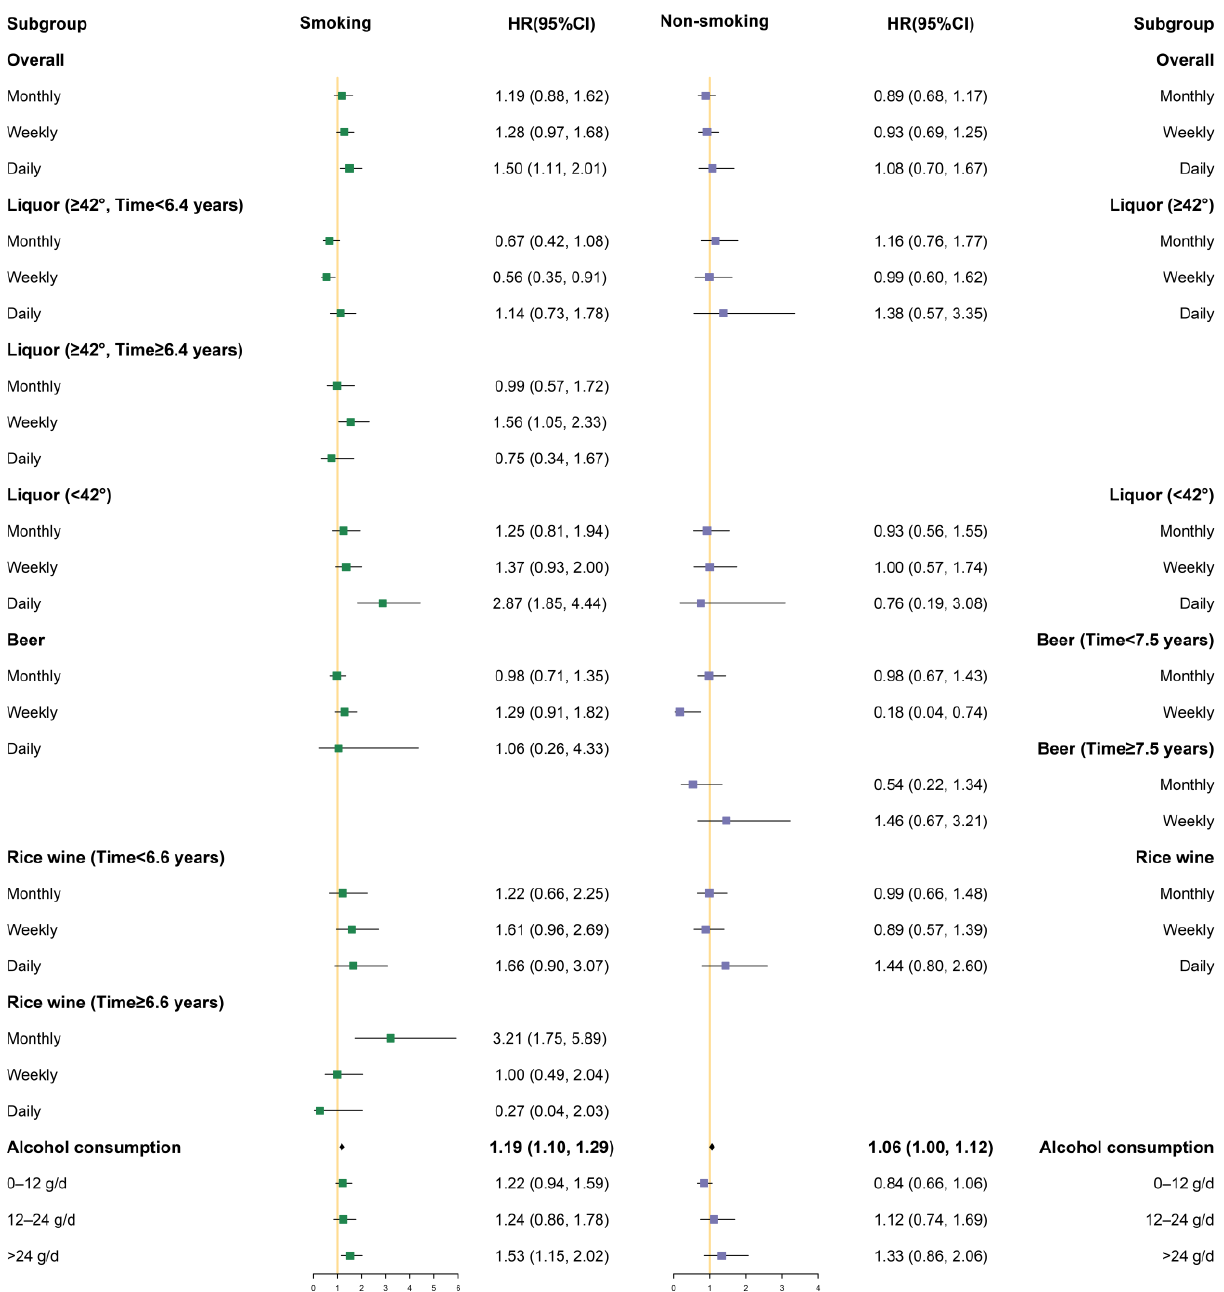
Figure 5. Subgroup analysis after stratification by smoking (Model 3).